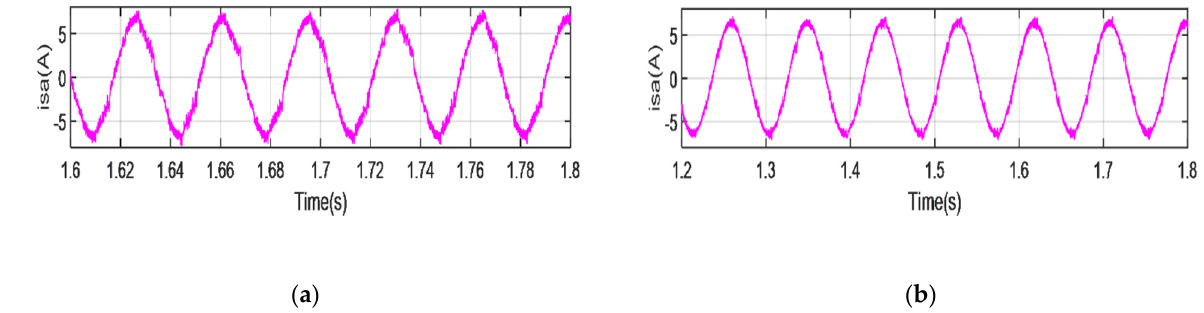
Figure 8. Torque response: ( a ) conventional inverter; ( b ) five-level inverter.